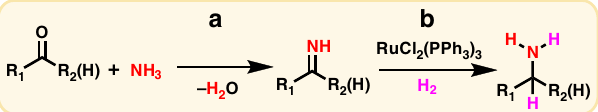
Fig. 5 Ru-catalyzed reductive amination of carbonyl compounds with NH 3 using H 2 . a Noncatalytic condensation reaction; b catalytic hydrogenation